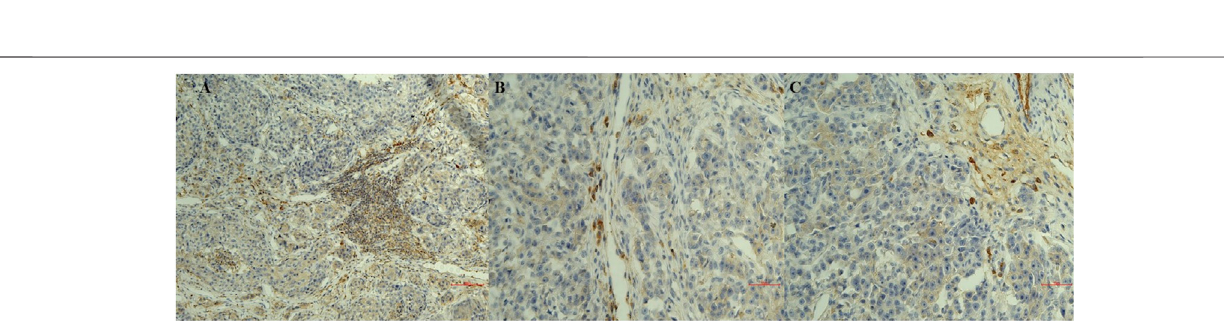
FIGURE 2 | Sections of immunostaining with a polyclonal anti-CD20 + mab of canine mammary sections from animals affected by breast cancer. (A) CD20 + Lymphocyte in fi ltrating tumor sample (20X) in a G1 sample; (B) CD20 + Lymphocyte in fi ltrating tumor sample (20X) in a G2 sample; (C) CD20 + Lymphocyte in fi ltrating tumor sample (20X) in a G3 sample.